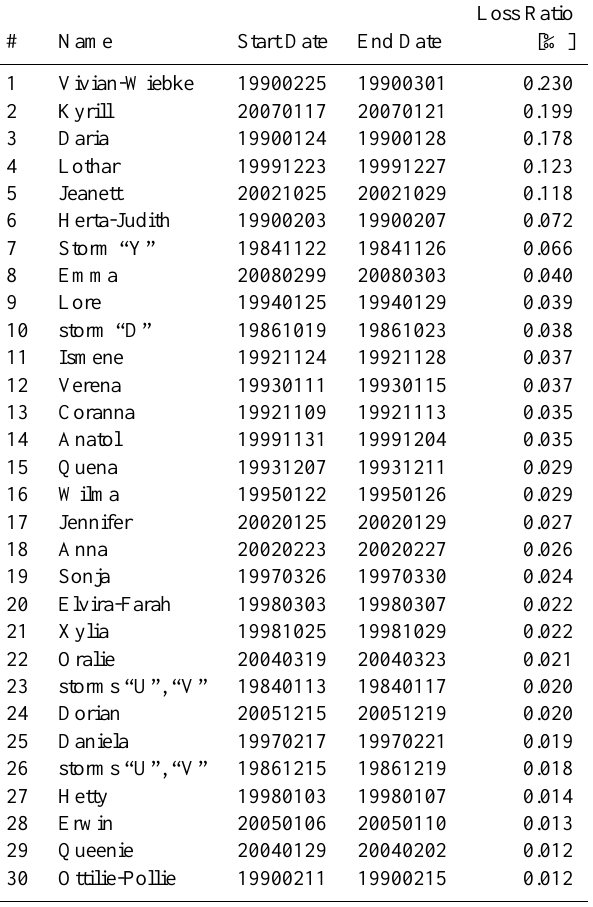
Table 2. The 30 most loss-intensive winter storm events identi- fied from VGV Sim insurance records 1984–2008 and the associ- ated 5-day periods. The names of the associated cyclones are indi- cated, start and end date of the five-day periods, and Germany-wide loss ratio sum for this period. Note that before 1990 cyclones were mostly denoted only by capital letters.